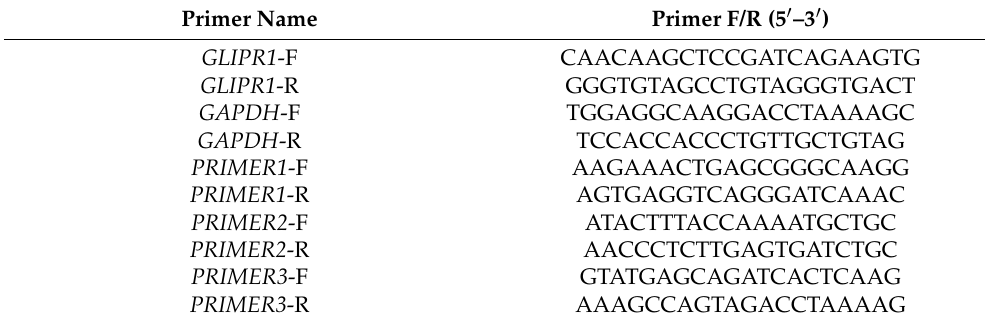
Table 1. Real-time quantitative PCR primes of GLIPR1 and GAPDH and promoter primers of